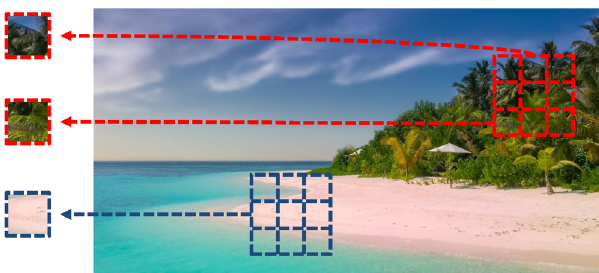
Fig. 2 Learning patch similarity from spatial distances. Our premise is that two patches sampled from the same swatch (colored in red) are more likely to be similar to each other than to a patch sampled from a distant one (colored in